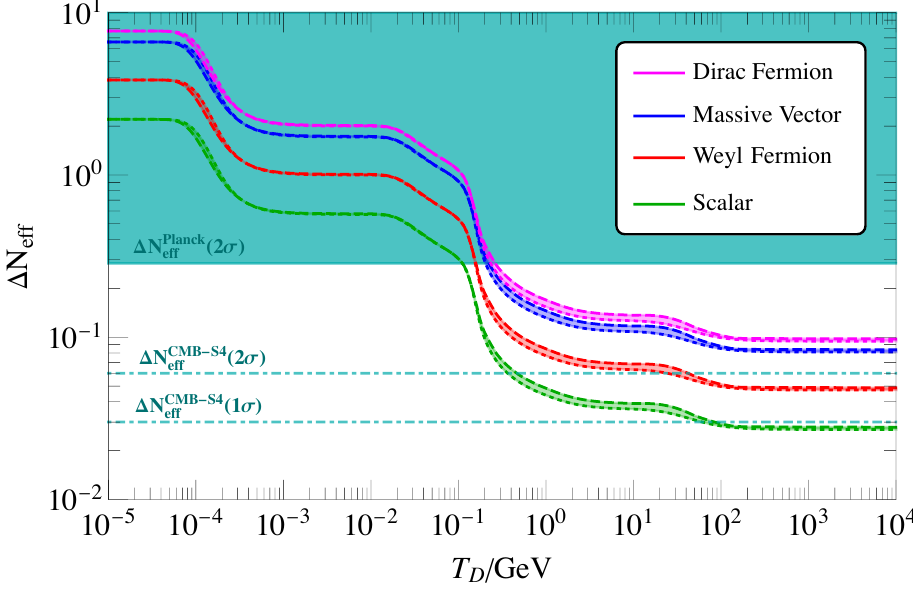
Figure 1 . Contribution to ∆ N eff from light relics that were once in thermal equilibrium as a function of the decoupling temperature T . Different colors represent different particle spins, and D the width of each line corresponds to the two different treatments of the relativistic degrees of freedom provided in refs. [32] (dashed lines) and [33] (dashed lines). The shaded region is excluded by Planck [27], the dot-dashed lines show the CMB-S4 discovery reach [28,